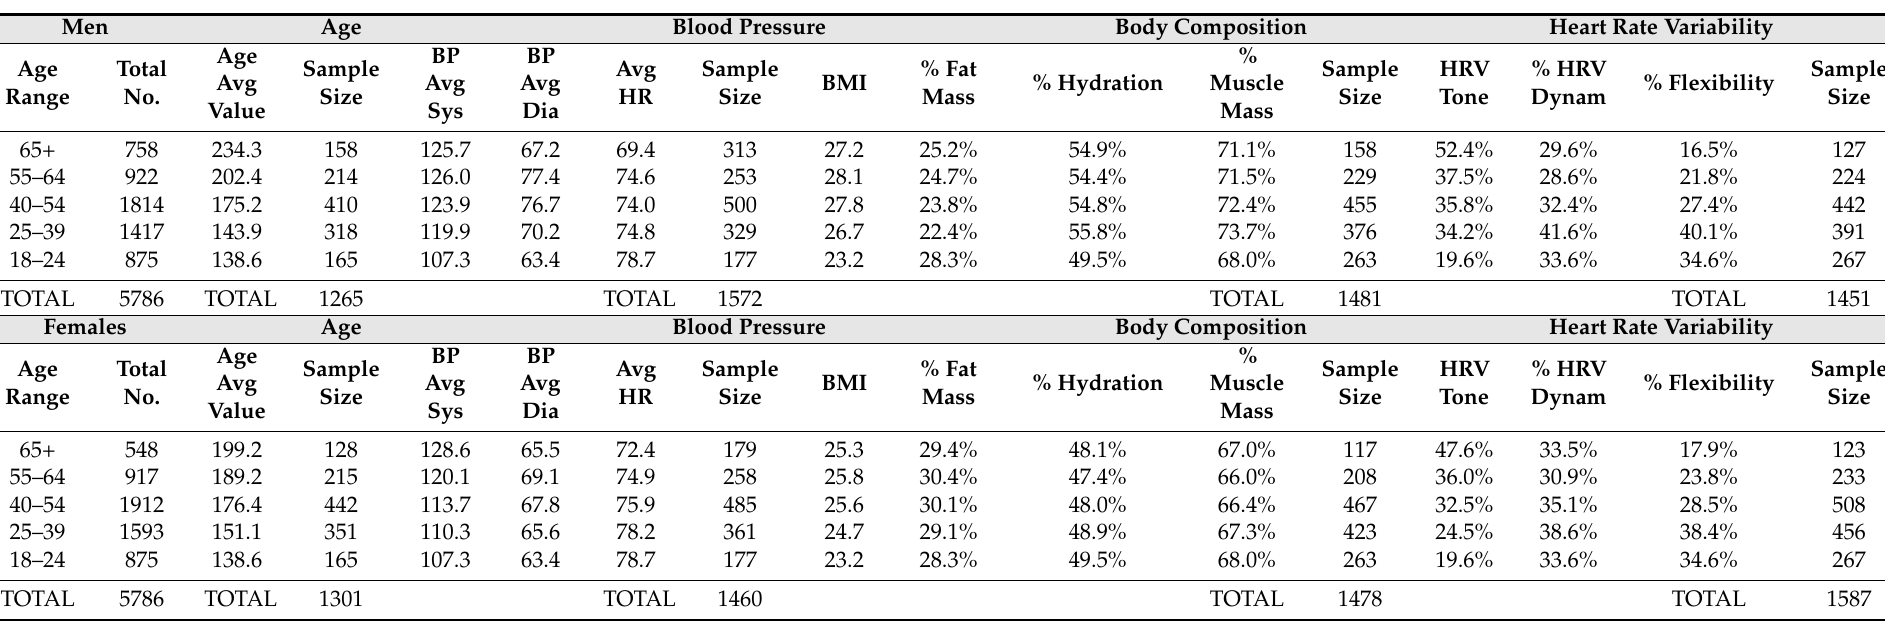
Table 3. Health data of male and female subjects divided per age range for the S1 + S2